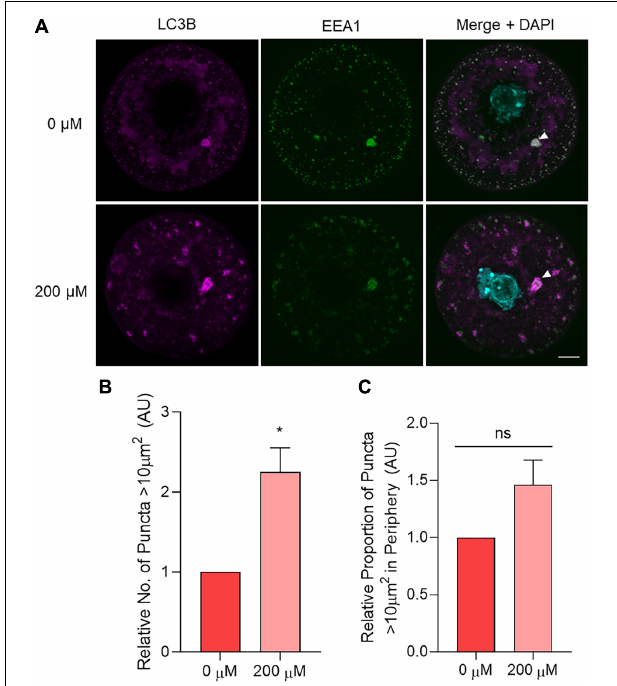
FIGURE 10 | The effect of chemical lysosomal inhibition using chloroquine on LC3B and EEA1 immunolocalization in young oocytes. Oocytes from young (4–6 weeks old) mice were treated for 6 h with 0 µ M (control) or 200 µ M chloroquine before fixation and labeling with anti-LC3B antibodies (pink), anti-EEA1 antibodies (green), nuclear counterstaining with DAPI (cyan), confocal imaging (60 × objective), puncta analysis, and peripheral analysis using Fiji. (A) Representative images demonstrate staining of LC3B and EEA1 in control and treated oocytes where white arrow points to example of large puncta. Scale bar = 10 µ m. (B) Comparison of the number of LC3B labeled puncta > 10 µ m 2 in control and treated oocytes (normalized to untreated control). (C) Comparison of the proportion of LC3B labeled puncta > 10 µ m 2 that resided in the periphery (outermost 10 µ m) of the oocyte (normalized to untreated control). N = 3, * P < 0.05, ns, not